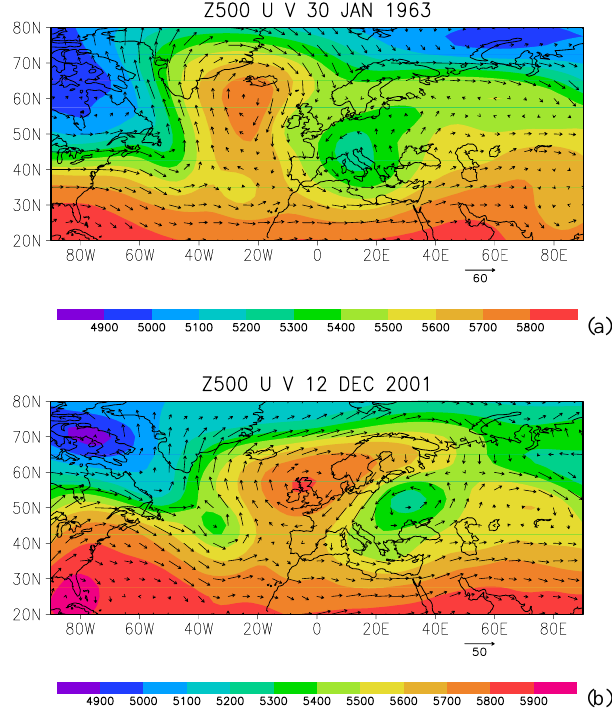
Fig. 6. Upper atmospheric circulation (500mb) for the blocking events that occurred on (a) 30 January 1963 and (b) 12 Decem- ber 2001. Colour (Z500), vector (wind). Units m and ms − 1